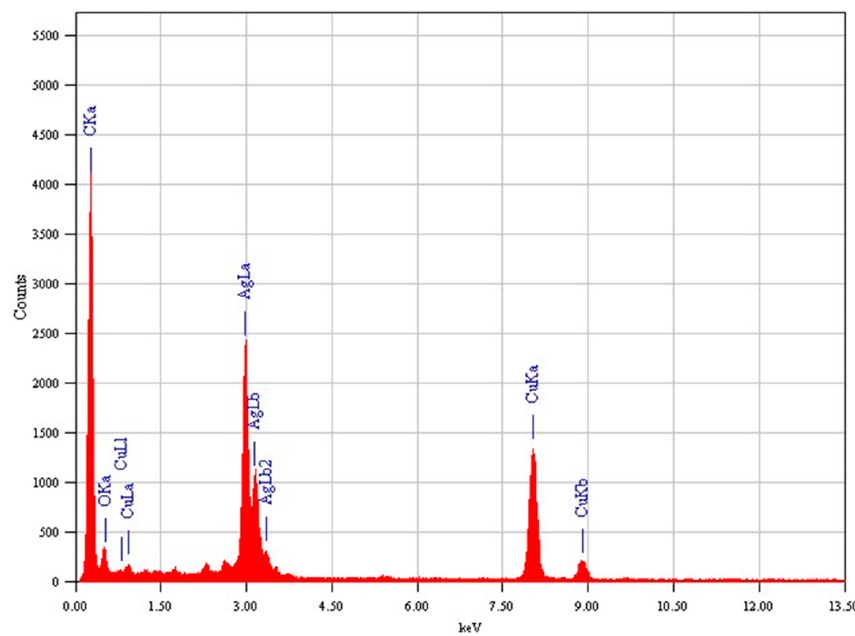
Figure 5. TEM-led EDS spectra of Ag/RGO NCs.